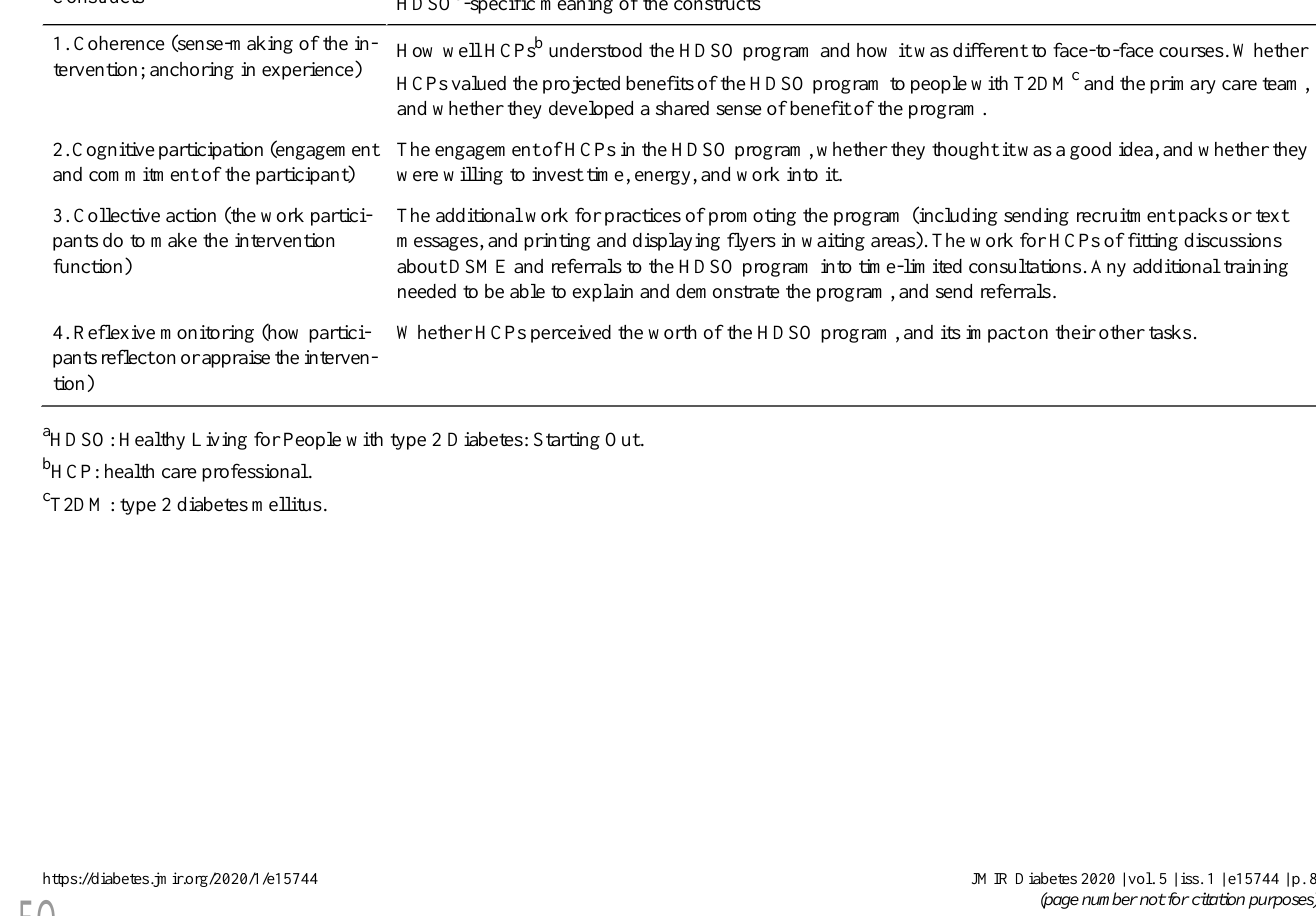
Table 6. Normalization process theory constructs and Healthy Living for People with type 2 Diabetes: Starting Out –specific meanings of the constructs. HDSO a -specific meaning of the